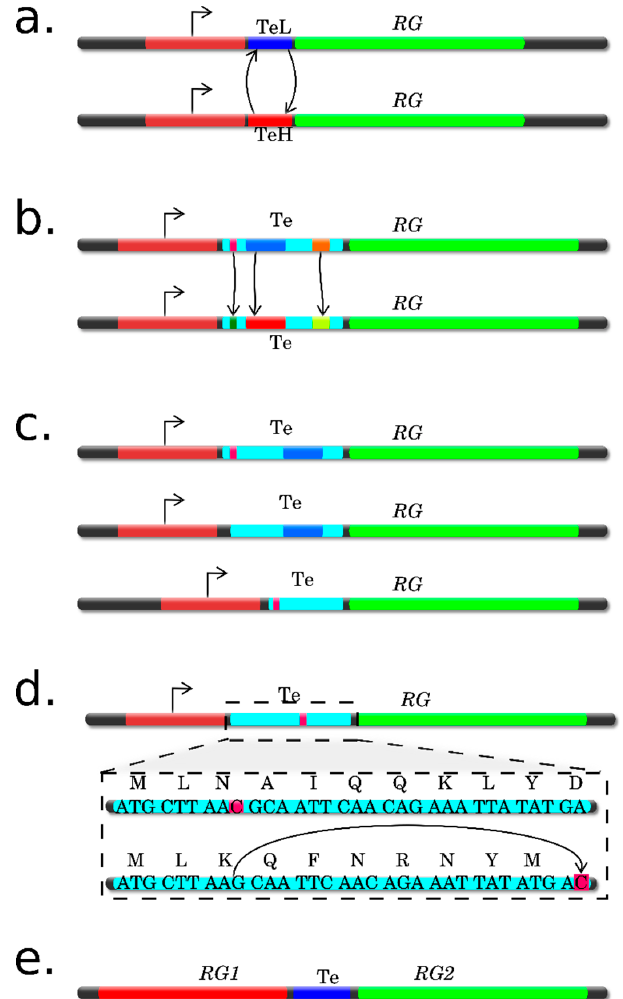
Figure 7. Approaches to experimental verification of the tested regulatory elements using the strategy of reporter systems. ( a ) Combinatorial approach. Mutual substitutions of the predicted regulatory motifs TeL and TeH (denoted with arrows) are introduced into the pairs of 5’UTRs of the same length but considerably differing in the experimentally confirmed translation efficiencies. TeL and TeH are the tested elements characteristic of the transcripts with low and high translation efficiencies, respectively. ( b ) Site-specific mutagenesis. The native regulatory sequence is above and the mutant regulatory sequence is below; different colors denote the region used for mutagenesis; direct arrows indicate the substituted regions in two sequences. ( c ) Deletion analysis. The native regulatory sequence is above; different colors denote the regions used for deletions: the regulatory region with deletion in the 5’ region is in the middle (deletion of the pink region of the native sequence) and the regulatory region with deletion in the 3’ region is below (deletion of the blue region of the native sequence). ( d ) Frameshift analysis. The region for introducing frameshift is dashed; the native nucleotide and amino acid sequences are above and the mutant, below. The nucleotides colored red were frameshifted. Simultaneous introduction of deletions and insertions to positions –1 and +1 changes the amino acid composition of peptide sequence encoded by the alternative open reading frame preserving the presence of the overlapping peptide and its length. ( e ) Bicistronic construct for studying the functionality of IRESs. Two reporter genes are translated from the bicistronic construct in a coordinated manner; translation of one of them (RG2) is controlled by the tested element (Te) and the other (RG1) is translated according to the classical cap-dependent mechanism. In all panels, bent arrows denote the transcription start point; Te, tested element; and RG, reporter gene.